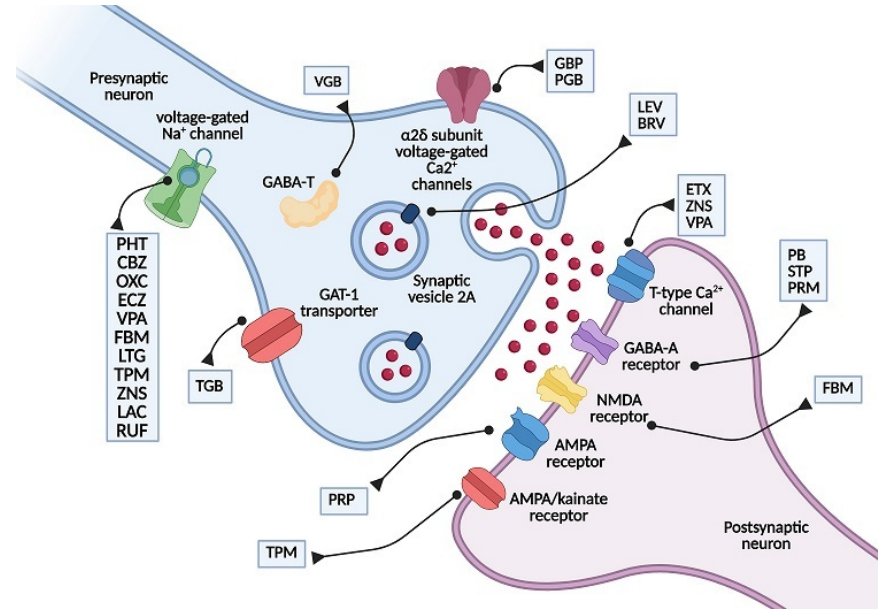
Figure 1. Mechanism of action of commonly used ASMs (Created by